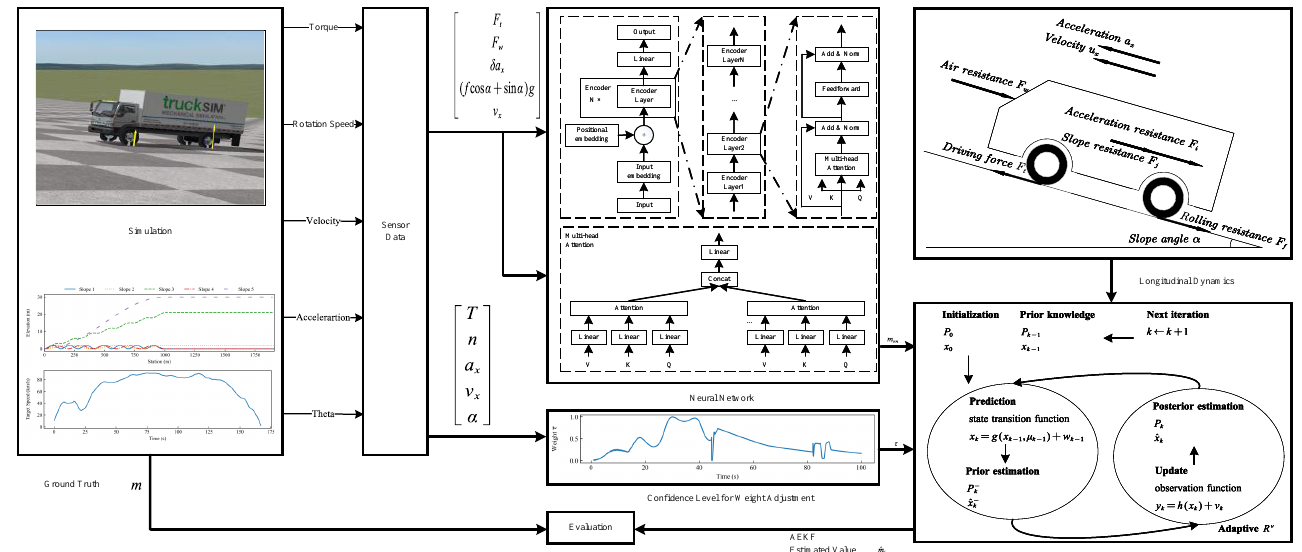
Figure 1. The framework of the proposed TA-AEKF estimator.